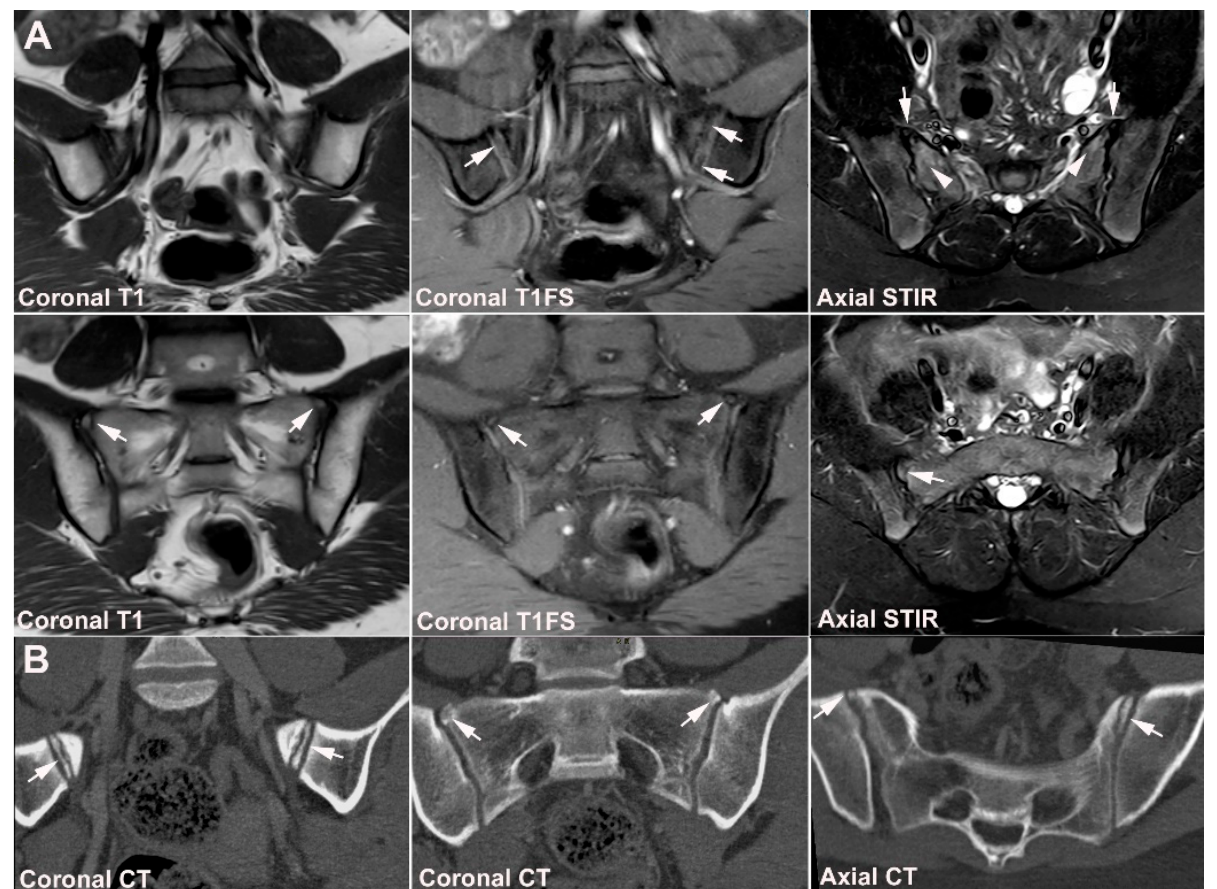
Figure 10. Unfused nucleus at the sacral wings and at the border between S1 and S2 in adulthood. ( A ) MRI in a 20-year-old healthy woman [40], semi-coronal T1 and T1FS, and semi-axial STIR images, upper image row anteriorly at the border between S1 and S2 and lower row more posteriorly in the joint at S1. There is persistence of small nuclei at the sacral wings posteriorly and at the border between S1 and S2 anteriorly (arrows) causing subchondral edema, especially at the S1/S2 region (arrowhead). ( B ) CT images obtained one year previously, semi-coronal and semi-axial reconstructions more clearly show the unfused nuclei both at the sacral wings and in the joint space (arrows).